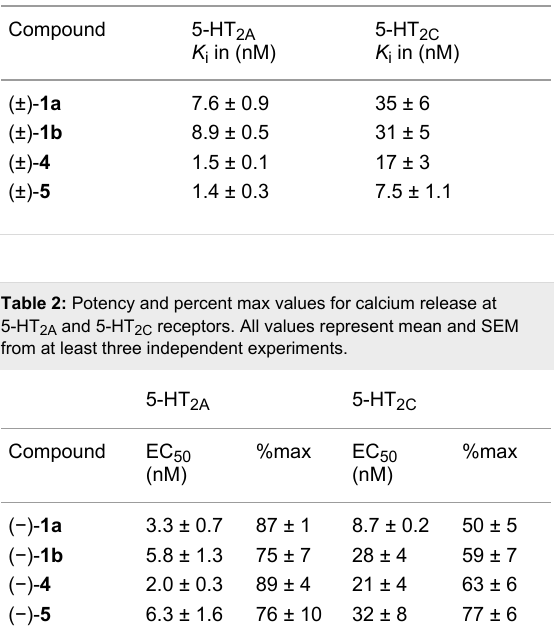
been reported, this substance has been scheduled in a number of countries and has been considered for scheduling by the U.S.